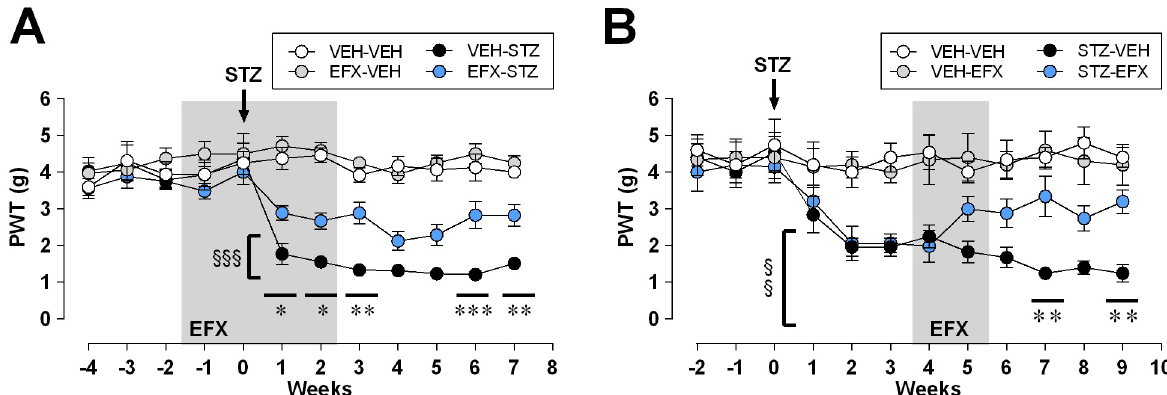
Fig 1. Preventive (A) and post-symptomatic (B) etifoxine action on von Frey paw withdrawal thresholds (PWT) following STZ-induced diabetic neuropathy (n = 10 per group). STZ injection was performed at week 0 (arrows), and treatment period is indicated in grey for a 4-week preventive (panel A) and a 2-week post-symptomatic EFX treatment (panel B). Statistical significance was assessed with Tukey’s multiple comparison test, illustrated as follows: p < 0.05 ( � ), p < 0.01 ( �� ) or p < 0.001 ( ��� ) for comparisons between VEH and EFX-treated STZ groups and p < 0.01 (§§), p < 0.001 (§§§) for comparisons between STZ-VEH and its control VEH-VEH at each time point.